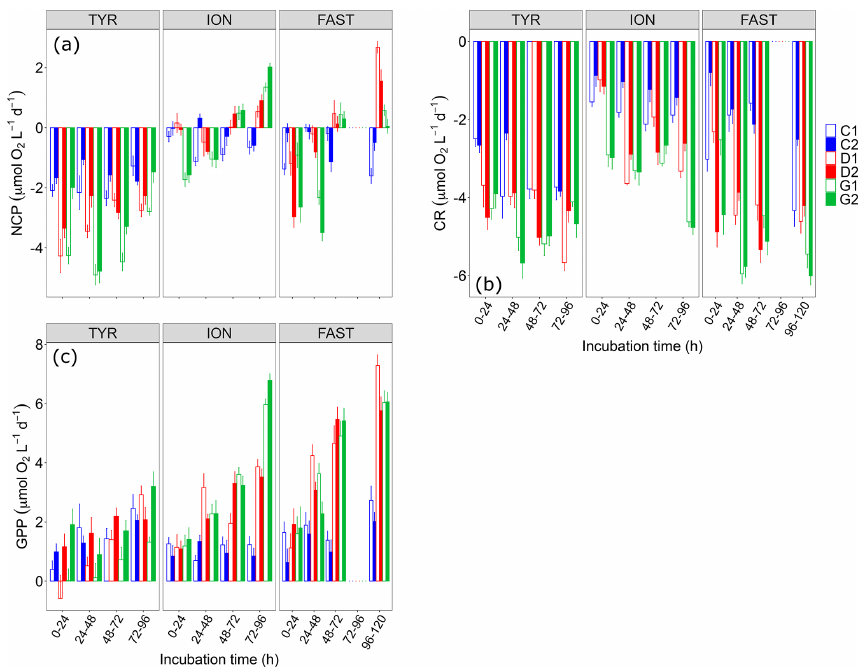
Figure 6. (a) Net community production (NCP), (b) community respiration (CR) and (c) gross primary production (GPP) rates estimated using the oxygen light–dark method (24h incubations) on samples taken in the six tanks (C1, C2, D1, D2, G1 and G2) during the three experiments (TYR, ION and